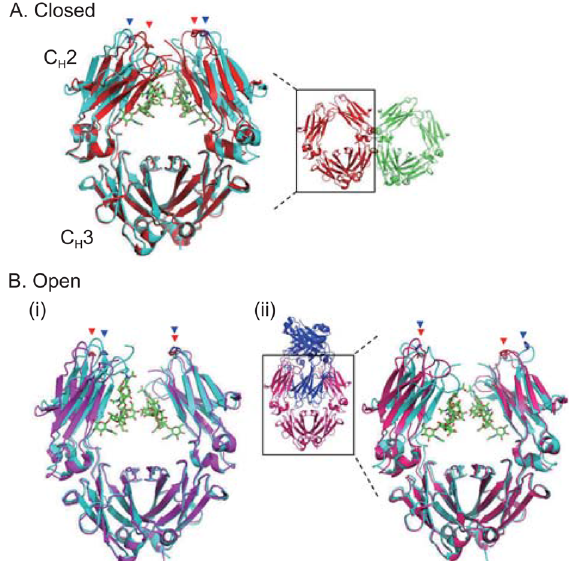
Figure 2. Comparison of nonglycosylated and glyco- sylated Fc structures. (A) Closed conformation of the nonglycosylated Fc. Superposition of the E . coli -produced aglycosylated human IgG1-Fc (red) (PDB ID code: 3S7G) with the glycosylated human IgG1-Fc (cyan) (PDB ID code: 3AVE). Overall structure of the two aglycosylated Fc molecules is shown in red and green, and the Fc shown in red is superimposed with the glycosylated Fc. (B) Open conformation of the nonglycosylated Fcs. (i) Superposition of the enzymatically deglycosylated human IgG1-Fc (ma- genta) (PDB ID code: 3DNK) with the glycosylated human IgG1-Fc (cyan) (PDB ID code: 3AVE). (ii) Superposition of deglycosylated human IgG4-Fc myeloma protein Rea (pink) (PDB ID code: 4D2N) with the glycosylated IgG4- Fc (cyan) (PDB ID code: 4C54). Overall structure of the two interlocked Fc molecules is shown in pink and blue. The Fc shown in pink is superimposed with the glycosy- lated Fc. The Fc glycans are shown in green sticks. The Pro329 residues located in the FG loop of the C H 2 domains are indicated by red and blue arrowheads for the nonglycosylated and glycosylated C H 2 domains, respectively. The molecular models were produced